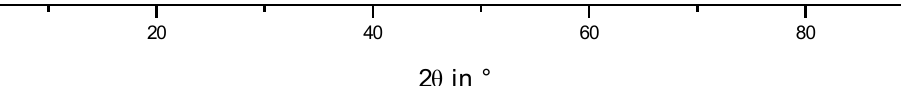
Figure A4. P-XRD of calcined iron catalyst before reaction (calc.) and after reaction.